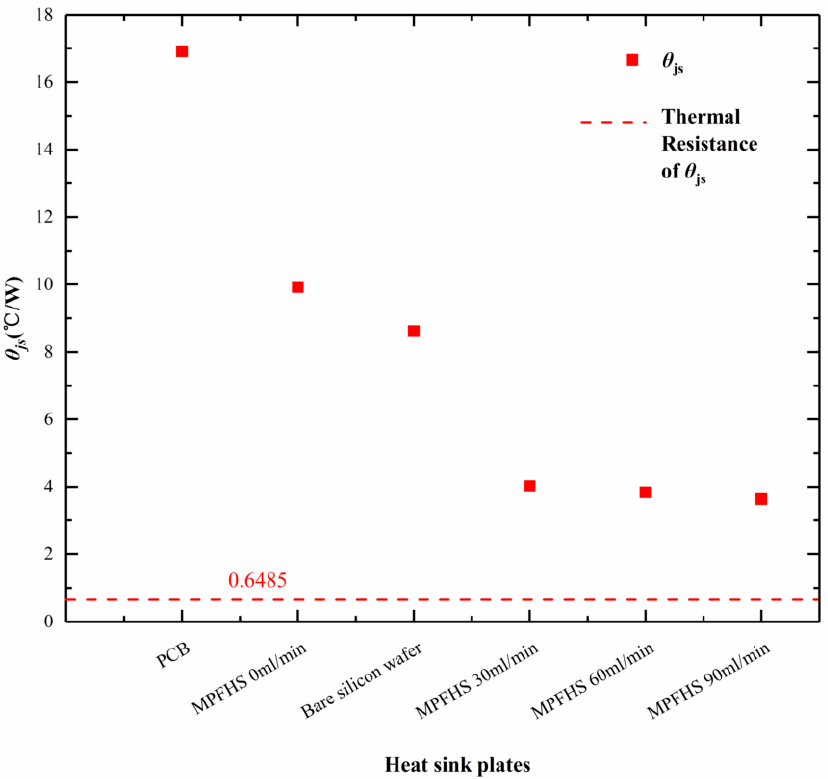
Figure 7. Decreasing trend of θ js and the theoretical limitation of 0.6458 °C/W